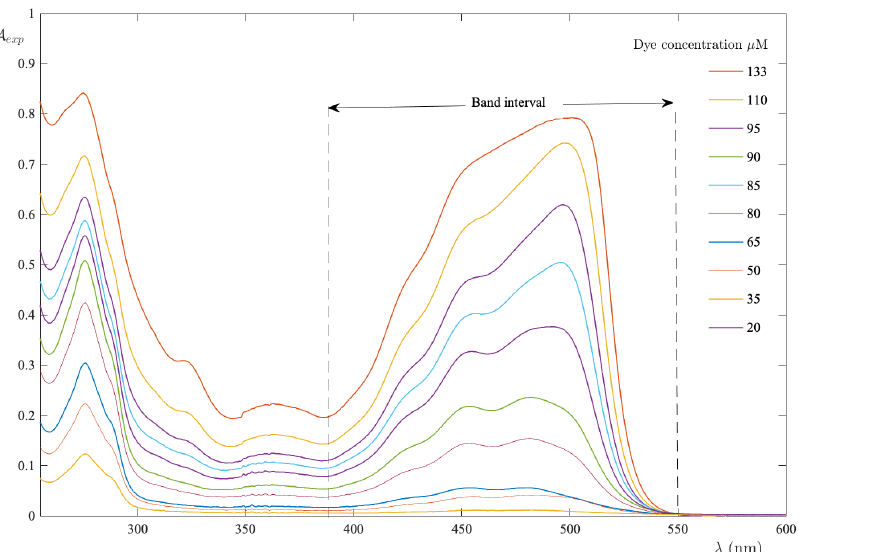
Figure 4. Absorption spectra recorded in the FS–ACN binary system as the dye concentration varies. Band interval indicates the range used to calculate the integral absorbance.